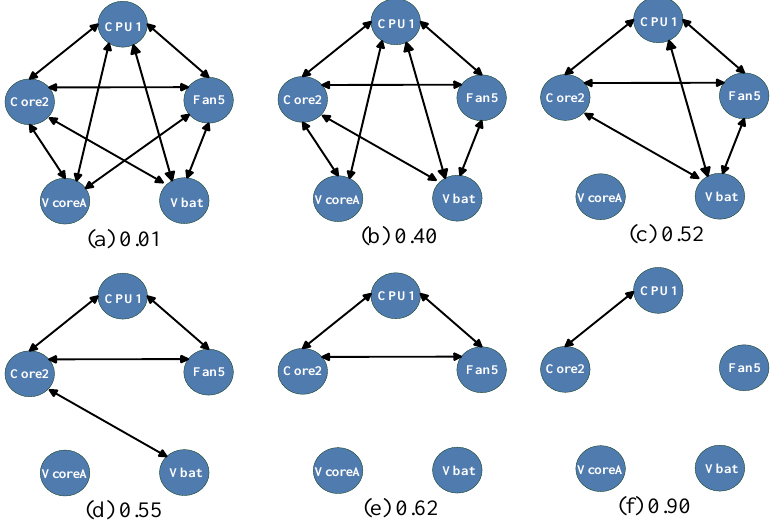
Figure 3. Correlation-based networks for thresholds of ( a ) 0.01, ( b ) 0.40, ( c ) 0.52, ( d ) 0.55, ( e ) 0.62, and ( f )